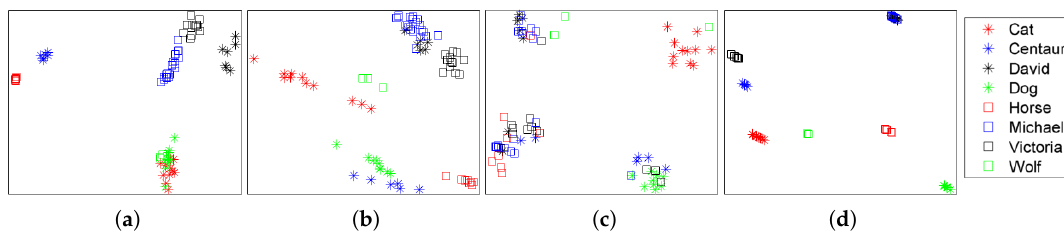
Figure 3. 2D PCA projection of shape descriptors computed from: ( a ) original Shape-DNA; ( b ) cShape-DNA; ( c ) GPS; and ( d ) LESI algorithms on TOSCA